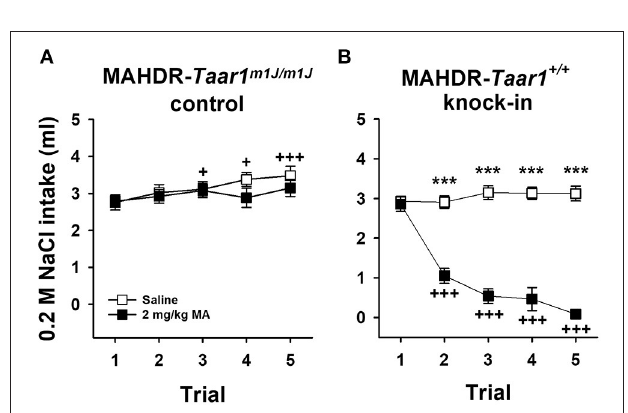
FIGURE 4 | MAHDR- Taar1 + / + KI mice, but not MAHDR- Taar1 m 1 J / m 1 J control mice, exhibit MA-induced conditioned taste aversion. Shown are means ± SEM for 0.2M NaCl intake in (A) MAHDR- Taar1 m 1 J / m 1 J control mice and (B) MAHDR- Taar1 + / + KI mice. Consumption trials were separated by 48h, and saline or 2 mg/kg MA injections (IP) were given immediately after 1h NaCl access for trials 1–4. Total N = 48 mice (6 per line per sex per treatment). *** p < 0.001 for the difference between treatment groups; + p < 0.05, +++ p < 0.001 for the difference compared to trial 1, collapsed on treatment (A) or within the MA treatment group (B) . MA, methamphetamine; MAHDR, methamphetamine high drinking mice; NaCl, sodium chloride; Taar1 + / + , homozygous reference trace amine-associated receptor 1 genotype; Taar1 m 1 J / m 1 J , homozygous mutant trace amine-associated receptor 1